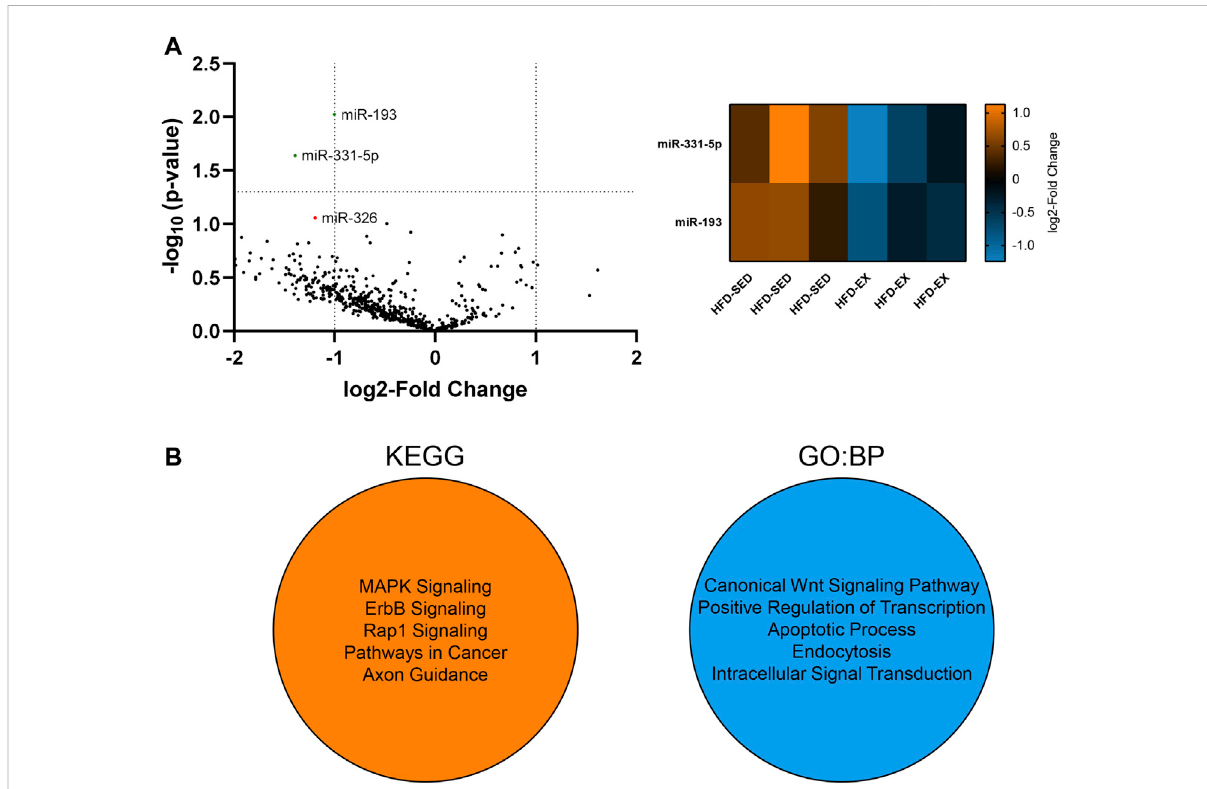
FIGURE 6 Extracellular vesicles (EVs) from high-fat diet exercise-trained (HFD-EX) mice have lower miR-331-5p ( p < 0.05) and miR-193 ( p < 0.01) expression comparedto HFD-sedentary(HFD-SED) mice. (A) Volcanoplotofall measuredmiRNAsandheatmap ofdifferentiallyexpressed miRNAs. miR-326 approached lower expression in HFD-EX EVs compared to HFD-SED ( p = 0.0877). The vertical dotted lines represent the margin for physiologically meaningful expression changes as per default ROSALIND analysis. The horizontal dotted line represents statistical signi fi cance ( p = 0.05). ( n = 3 per group). (B) Kyoto Encyclopedia of Genes and Genomes (KEGG) and Gene Ontology: Biological Processes (BP) predicted target pathways by miRWalk combined analysis of miR-193 and